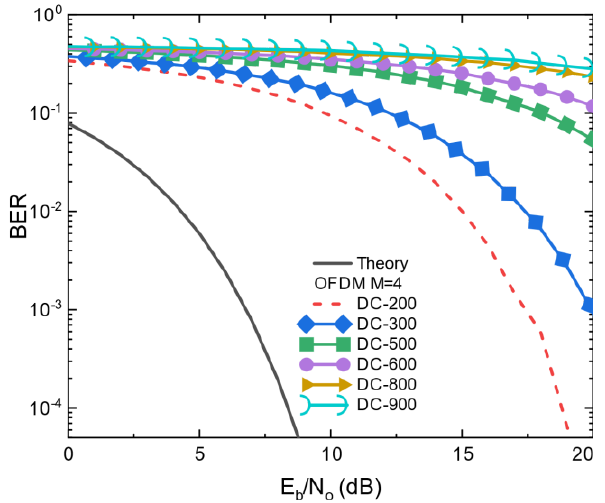
Figure 10. BER performance as a function of E b /N o for OFDM with 4-QAM and 600 AC.